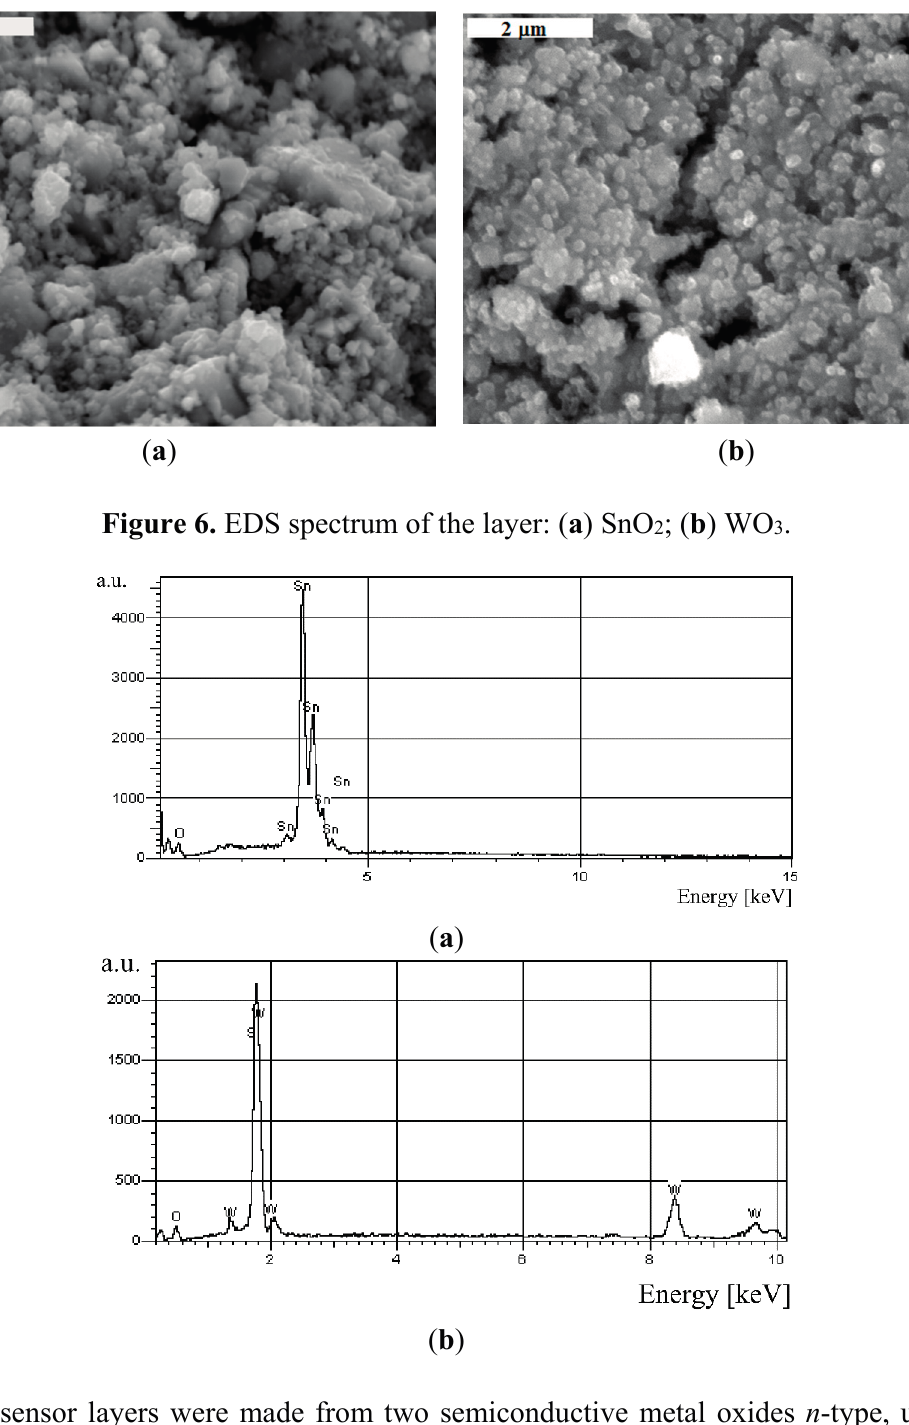
Figure 5. Surface microstructure of metal oxide layers: ( a ) SnO 2 ; ( b ) WO 3 .